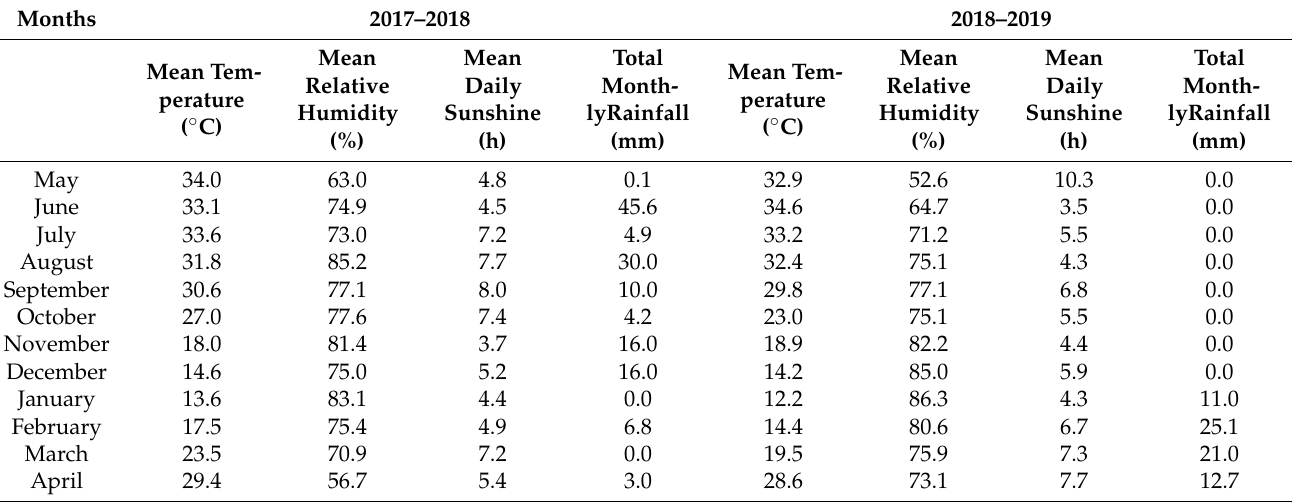
Table 1. Table 1. Weather data for the period of research at the experimental